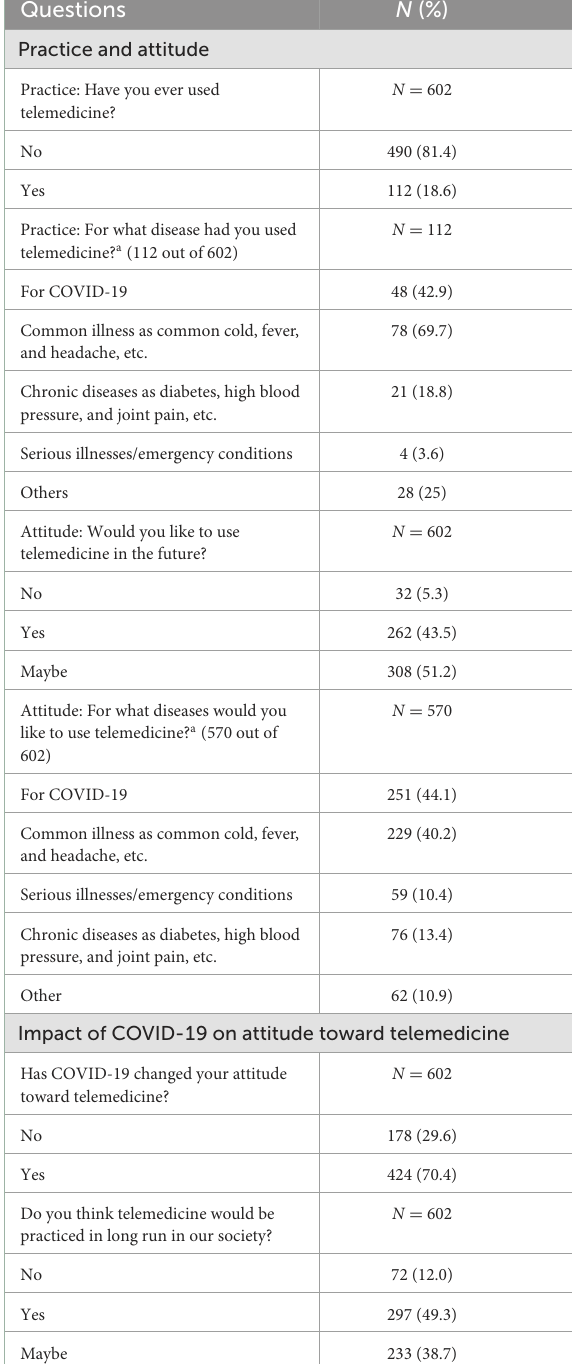
TABLE 3 Practices and attitudes toward